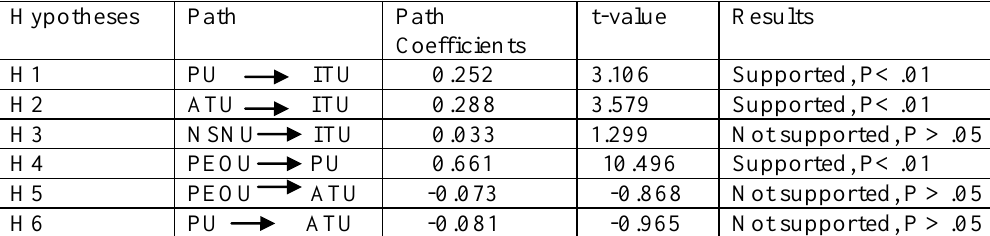
Results of Hypotheses Testing